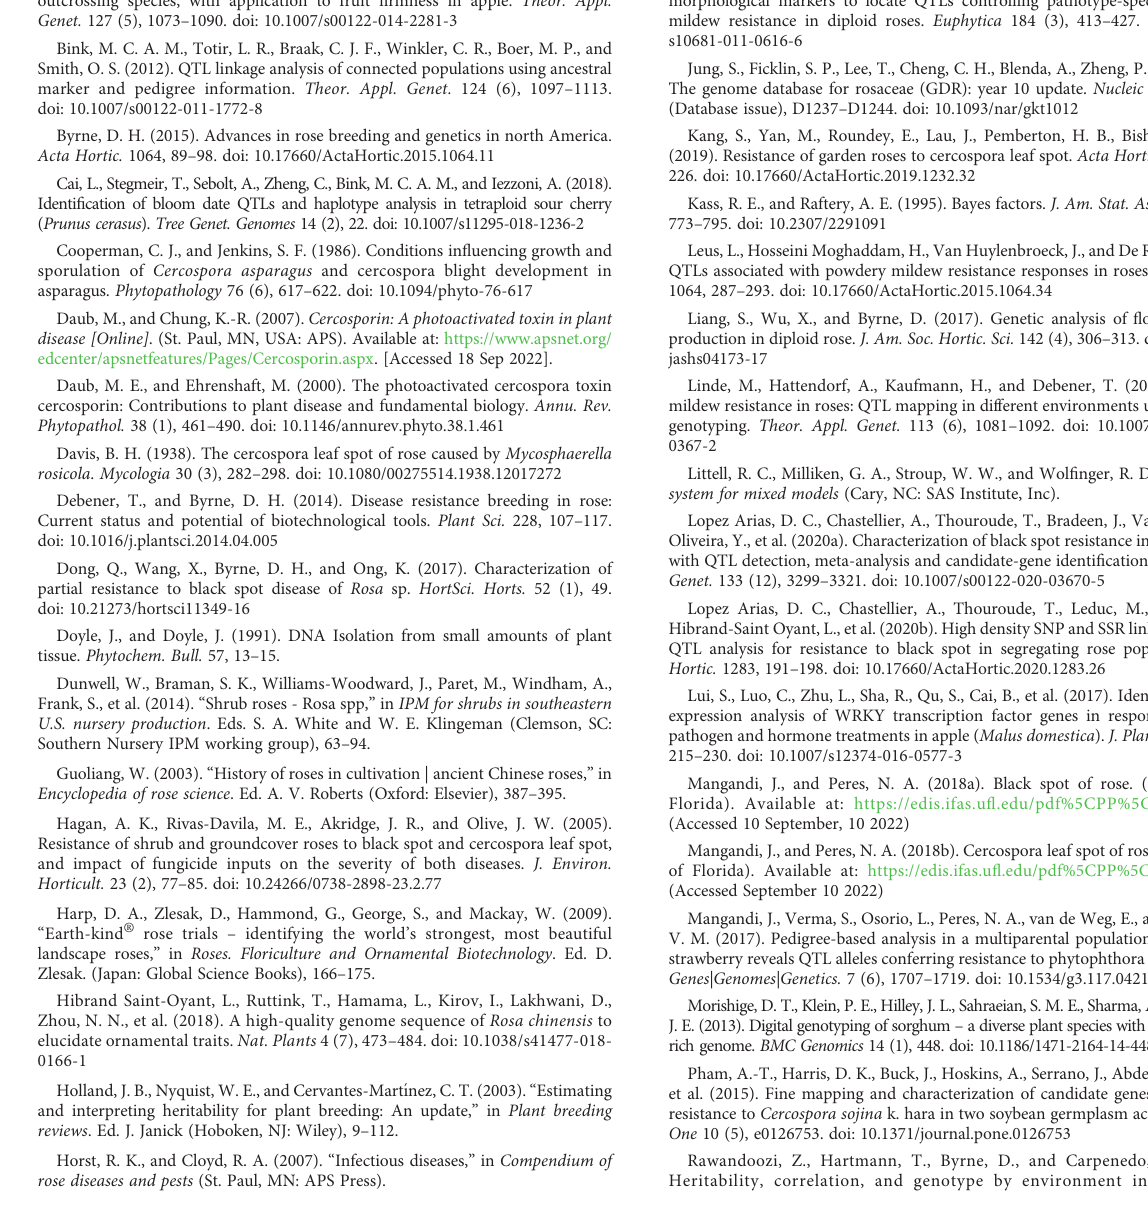
SUPPLEMENTARY FIGURE 13 Analysis of the compound QTL genotypes from qCLS.TX2WOB-LG3.2 and qCLS.TX2WOB-LG4.2 on cercospora leaf spot disease rating from all progenies in 11 diploid rose populations (TX2WOB). SUPPLEMENTARY FIGURE 14 Analysis of the compound QTL genotypes from qCLS.TX2WSE-LG3.1